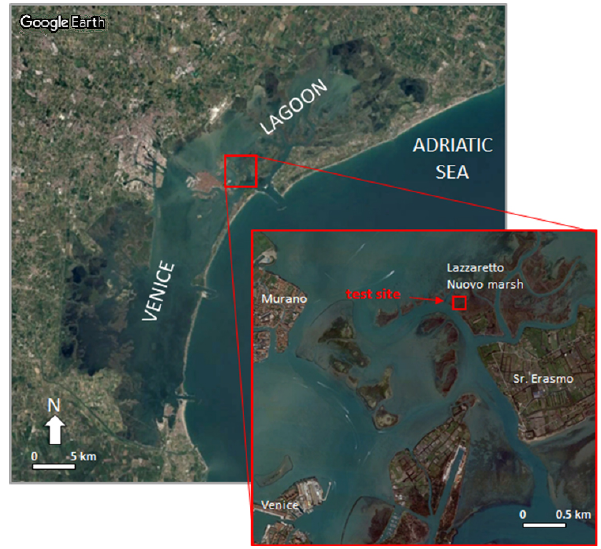
Figure 1. Location of the Lazzaretto Nuovo salt-marsh and the site where the loading test has been carried